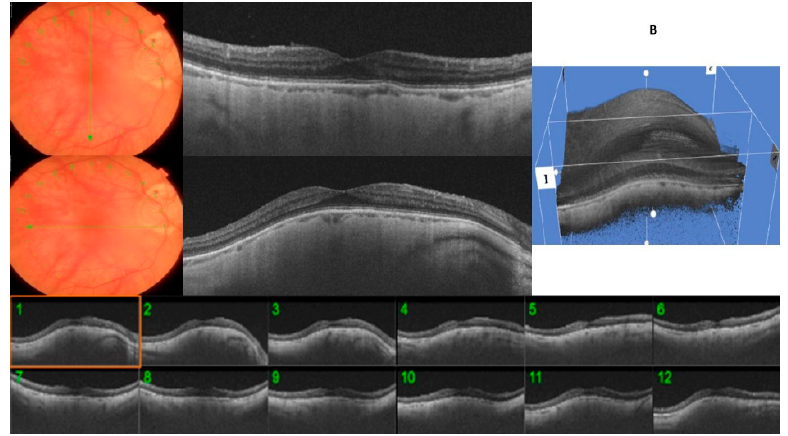
Figure 3. ( A )/( B ): A ridge ‐ shaped macula (RSM) with six radial OCT scans centered on the fovea showing an inward convexity of ≥ 50 μ m, whereas the macular curvature was unremarkable on opposite perpendicular meridians. ( A ): horizontally oriented RSM. ( B ): vertically oriented RSM. A statistical comparison between the RSM and DSM group showed no differences in mean age (65.1 ± 12.0 vs. 59.1 ± 14.1 years in RMS vs. DSM group respectively, Student’s t ‐ test, p = 0.15), spherical equivalent ( − 12.2 ± 7.6 vs. − 17.1 ± 3.7, Student’s t ‐ test, p = 0.14), logMAR BCVA (0.57 ± 0.58 vs. 0.30 ± 0.21, Student’s t ‐ test, p = 0.12), height of the inward convexity (272.7 ± 165.3 vs. 329.6 ± 194.8 μ m, Student’s t ‐ test, p = 0.32), retinal foveal thick ‐ ness (201.3 ± 64.8 vs. 195.9 ± 68.1 μ m, Student’s t ‐ test, p = 0.80), foveal scleral thickness (335.1 ± 115.5 vs. 368.0 ± 136.0 μ m, Student’s t ‐ test, p = 0.41), subfoveal choroidal thickness (116.9 ± 78.3 vs. 103.1 ± 52.3 μ m, Student’s t ‐ test, p = 0.57), and the presence of CNV (Fisher test, p = 0.73) or perforating scleral vessels (Fisher test, p = 0.31) (Table 1). Table 1. Comparison data between the DSM and RSM groups. DMS